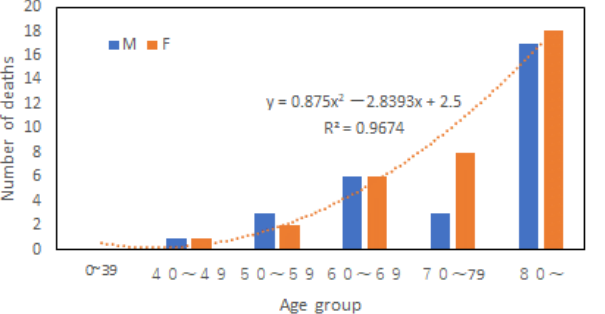
Figure 8. Death tolls in different age groups in the Kuma River flooding (Data source: e-Stat, Japan).